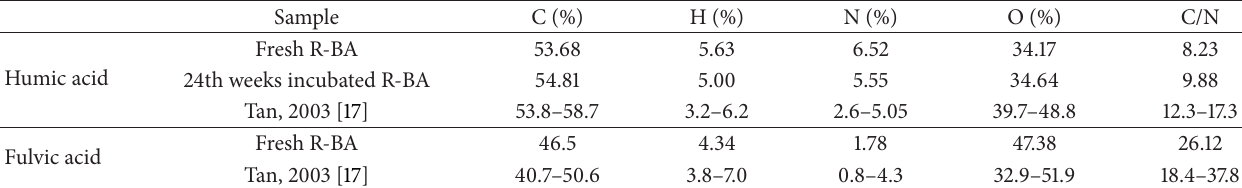
Table 1: Elementary analysis of humic substance extracted from R-BA.